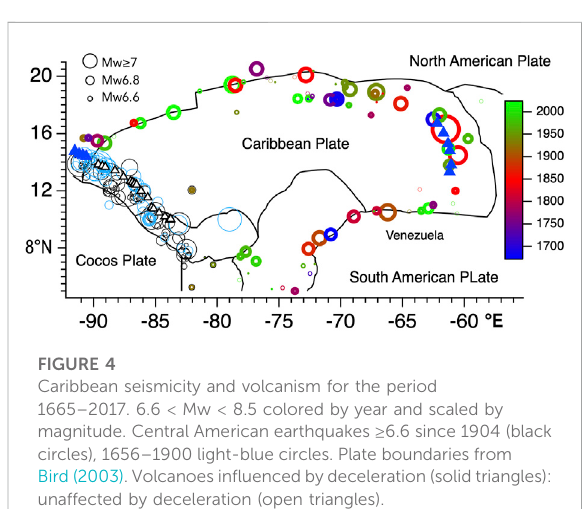
FIGURE 4 Caribbean seismicity and volcanism for the period 1665 – 2017. 6.6 < Mw < 8.5 colored by year and scaled by magnitude. Central American earthquakes ≥ 6.6 since 1904 (black circles), 1656 – 1900 light-blue circles. Plate boundaries from Bird (2003). Volcanoes in fl uenced by deceleration (solid triangles): unaffected by deceleration (open